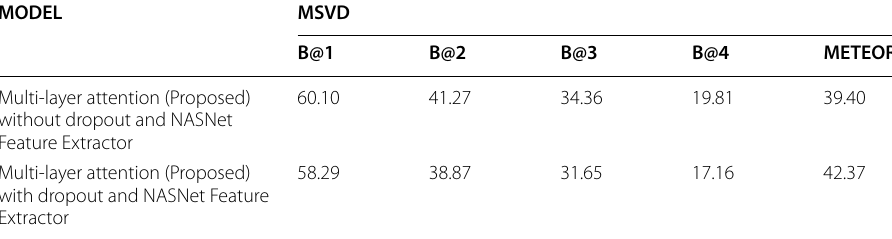
Table 5 Performance score with different Feature Extractor MODEL MSVD